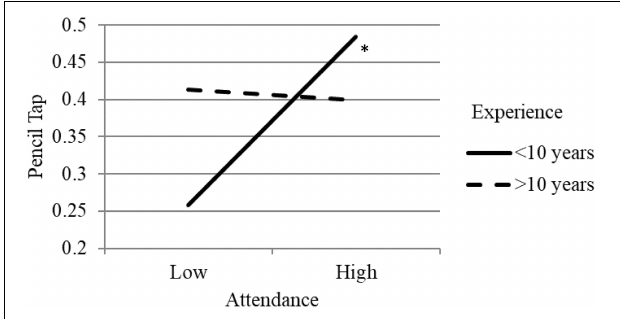
FIGURE 1 | Moderated effect of training attendance on children’s pencil tap scores by teacher years of experience. ∗ p < 0.05.